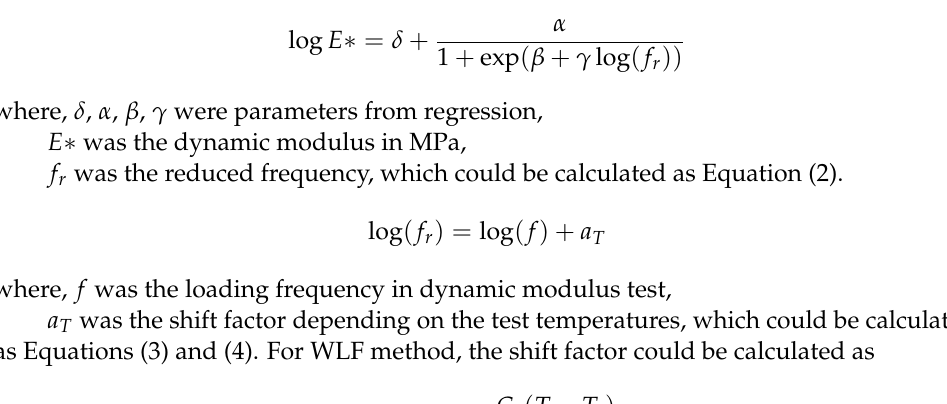
Figure 8. Dynamic modulus test results and fitted master curve with WLF and Arrhenius equation. To characterize the viscoelastic behavior of SFP, a sigmoidal master curve was fitted using two approaches, known as the WLF method and the Arrhenius equation [28]. The master curve could be expressed as Equation (1).